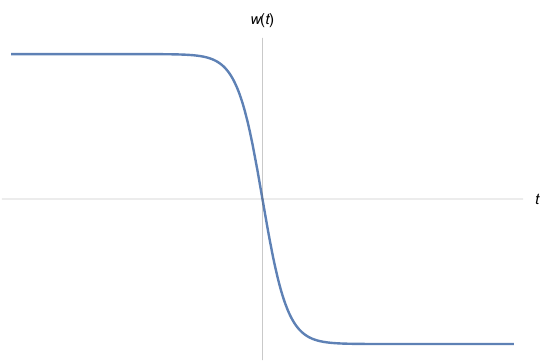
Figure 1 . The equation of state is an odd function of time, where the origin is precisely when the shifted dilaton is proportional to the dilaton, i.e., representing the self-dual point of the scale-factor